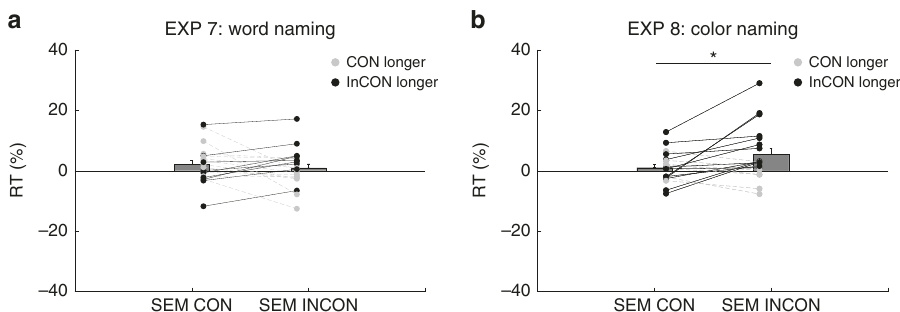
Fig. 5 Experiments 7 and 8 results. n = 20 in each experiment. Y -axis denotes reaction time, and X -axis denotes two critical conditions: semantically congruent (SEM-CON) and semantically incongruent (SEM-INCON). Black dots and lines denote longer RT in the semantically incongruent condition while gray dots and lines denote longer RT in the semantically congruent condition. Each pair represents one participant. The bars denote group mean with the error bars indicating standard error of the mean (SEM). Asterisk denotes signi fi cance (Exp 8, p = 0.02, 2-tailed paired t test from prime-target